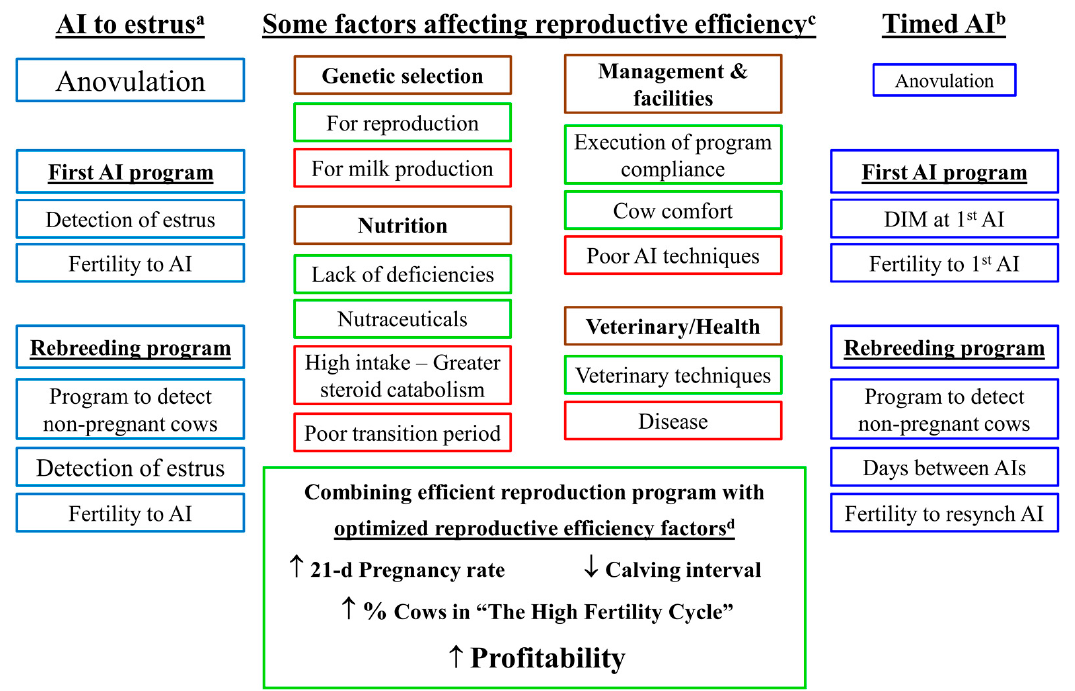
Figure 6. Representation of the key reproductive factors that directly affect a reproductive management program using artificial insemination (AI) to estrus ( left a ) or timed AI ( right b ). Some of the key factors that affect reproductive efficiency in either or both types of programs are shown ( center c ). Factors shown in red squares tend to decrease fertility, whereas factors shown in green rectangles tend to increase fertility. ( Bottom d ) Shows that implementation of effective reproductive management programs, combined with optimization of factors that alter reproductive efficiency allows farms to reach the goal of improved reproductive efficiency and profitability on a high-producing dairy farm. Days in milk